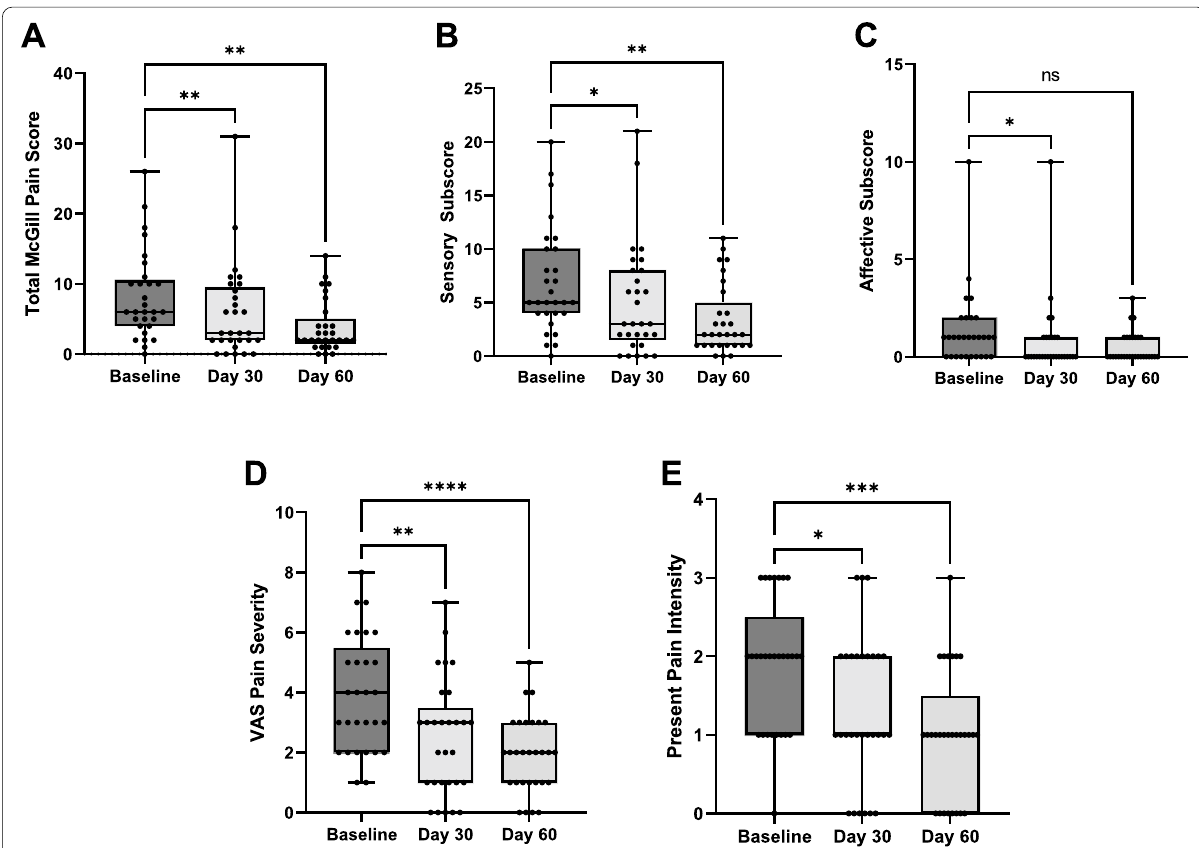
Fig. 2 Box and whisker plots of the Short‑Form McGill Pain Scores: A Total McGill Pain Score, B Sensory subscore, C Affective subscore, D VAS pain severity and E Present pain intensity. Statistical analyses were performed using the non‑parametric Friedman test followed by the Dunn’s multiple comparison post‑hoc test to identify changes from baseline. The following indicates the level of statistical significance; ns p > 0.05, * p < 0.05, ** p < 0.01, *** p < 0.001, **** p < 0.0001 ( n =